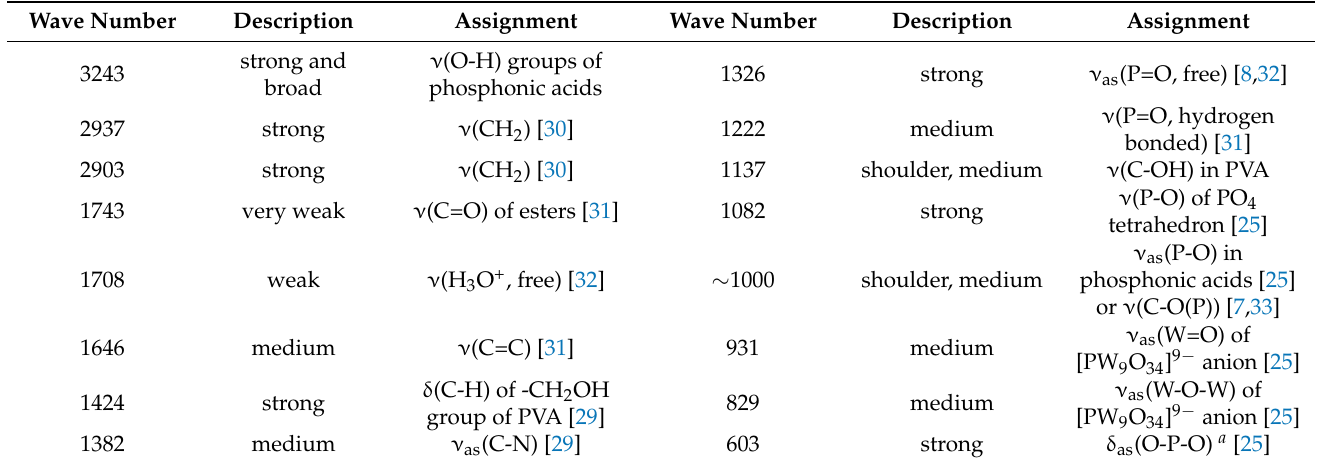
Table 1. Wavenumbers (cm − 1 ), relative intensities and the assignment for IR-bands of the membrane. Wave Number